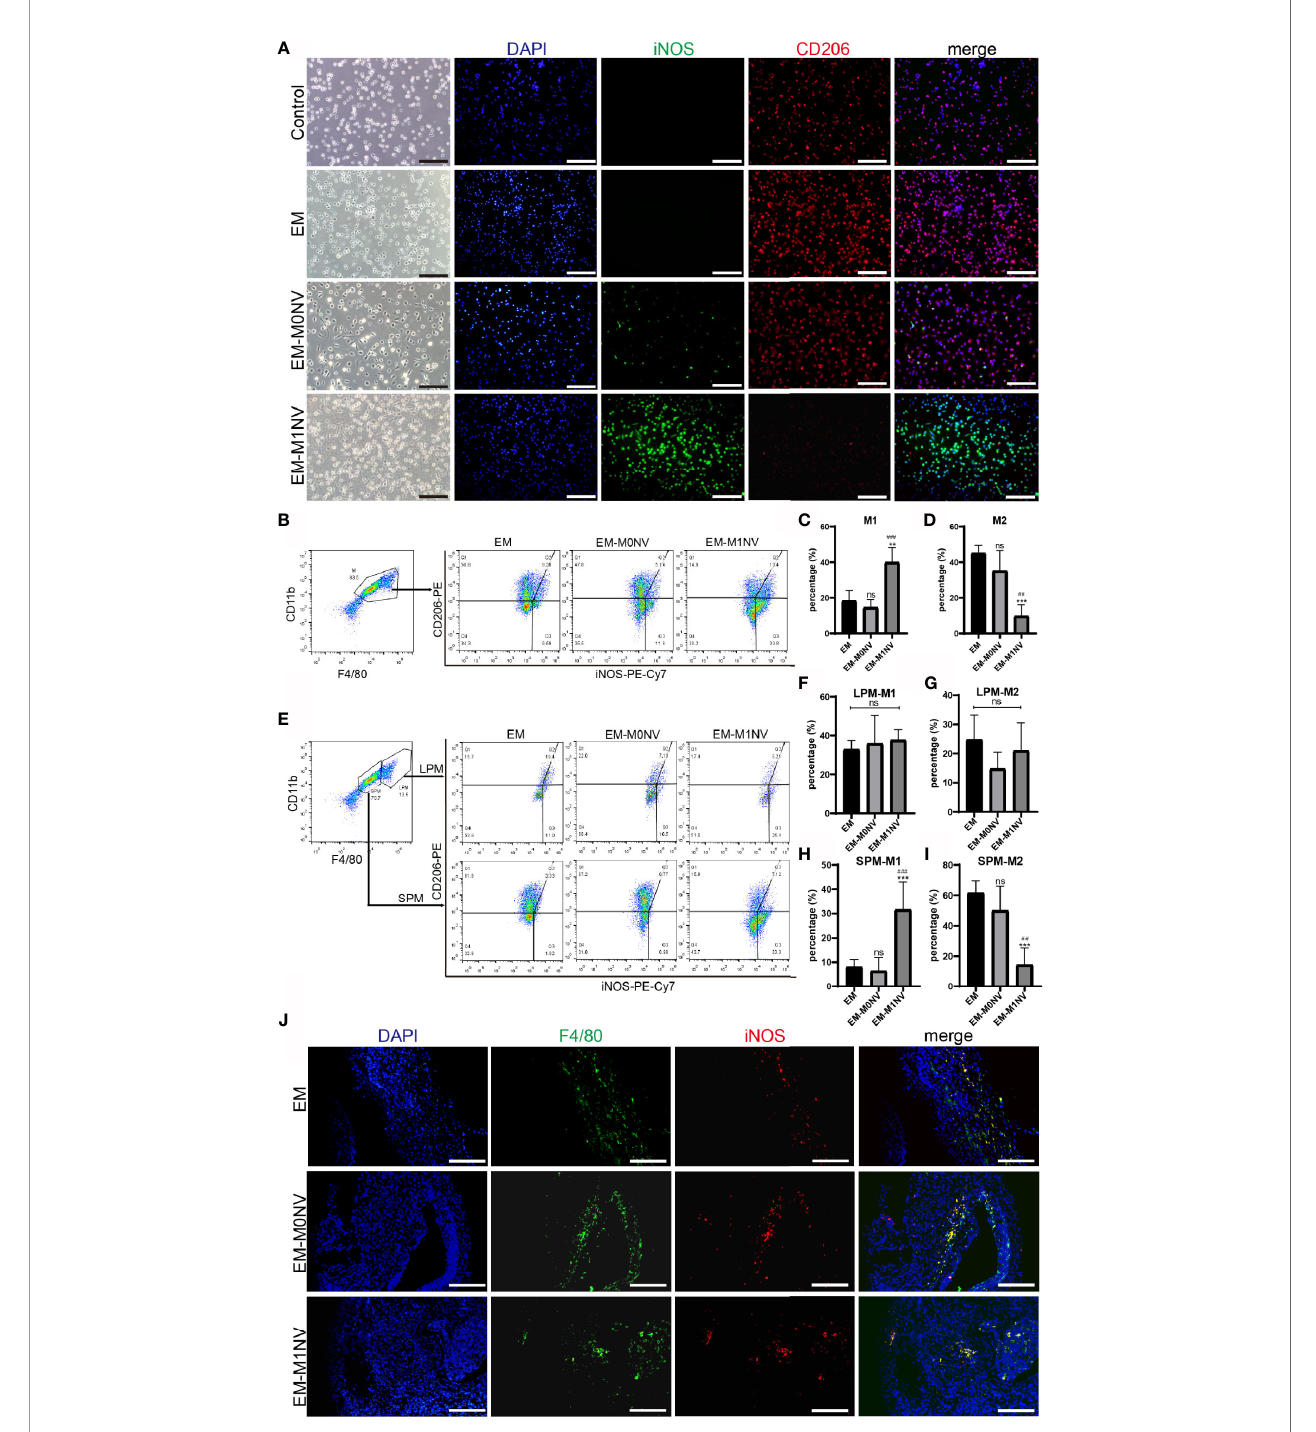
FIGURE 6 | M1NVs inhibited the development of endometriosis in vivo through reprogramming M2. (A) Immuno fl uorescence staining of peritoneal macrophages from different groups for iNOS (green, M1 marker) and CD206 (red, M2 marker) (Scale bar = 100 m m). (B – D) FCM analysis of the peritoneal macrophages from different groups showed that M1NVs treatment signi fi cantly increased M1 (C) and reduced M2 (D) macrophages in vivo . (E – I) FCM analysis of the polarization of LPMs and SPMs showed that the treatment of M1NVs signi fi cantly increased M1 and reduced M2 macrophages derived from SPMs (H, I) while little affected the polarization of LPMs (F, G) (ns, No signi fi cance when compared with EM. **P<0.01, ***P<0.001 when compared with EM. ## P<0.01, ### P<0.001 when compared with EM-M0NV). (J) Immuno fl uorescence staining of macrophages in endometriosis lesions from different groups for F4/80 (green, pan marker of macrophages) and iNOS (red, M1 marker) (Scale bar = 100 m